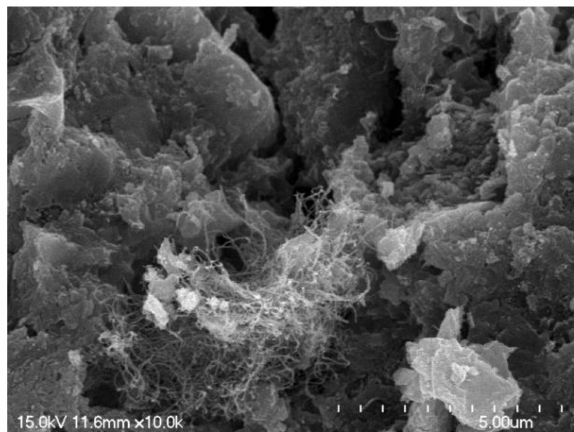
Figure 9. Agglomerated CNT in CRC05.